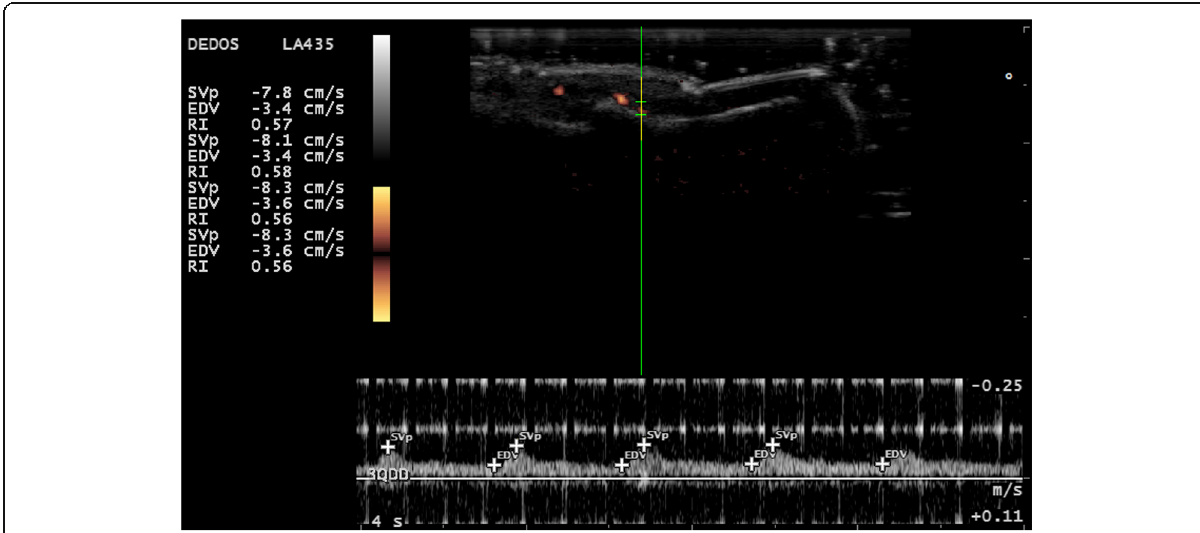
Fig. 2 RI measure by spectral doppler. Legend: SVp: maximum blood flow velocity in systole. EDV: diastolic blood flow velocity. RI: